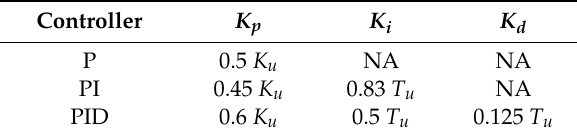
Table 1. Ziegler–Nichols test (Z–N) tuning